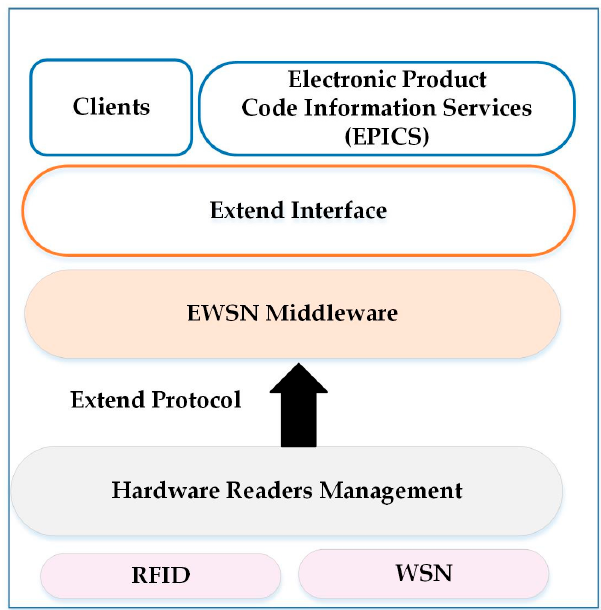
Figure 11. EWSN Sensor-based Architecture [94].